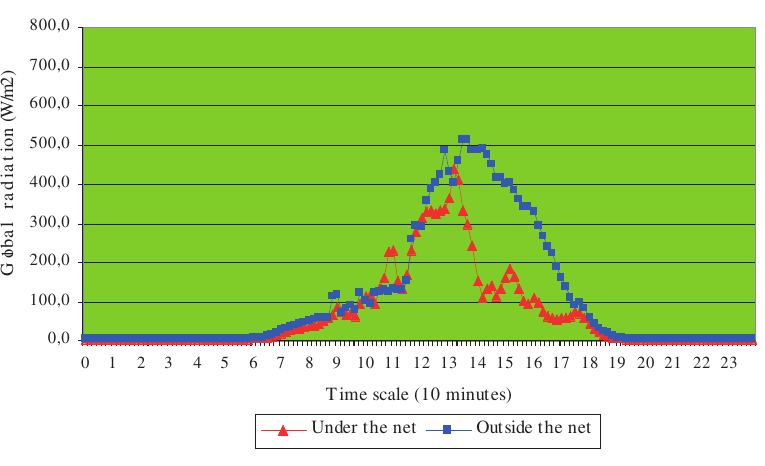
Figure 6. The mean daily course of the relative air humidity measured under the hail net and outside of it on a particularly calm day (RN <20%) /Pallag 2011 June 1 – September 30./ dif